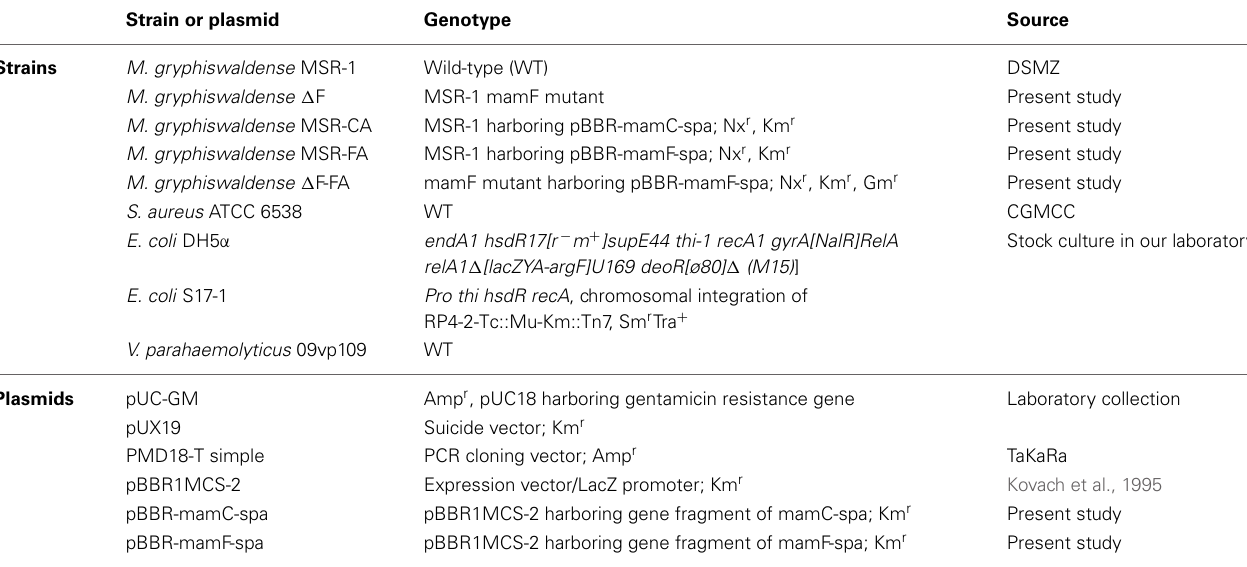
Table 1 | M . gryphiswaldense strains and plasmids in this study. Strain or